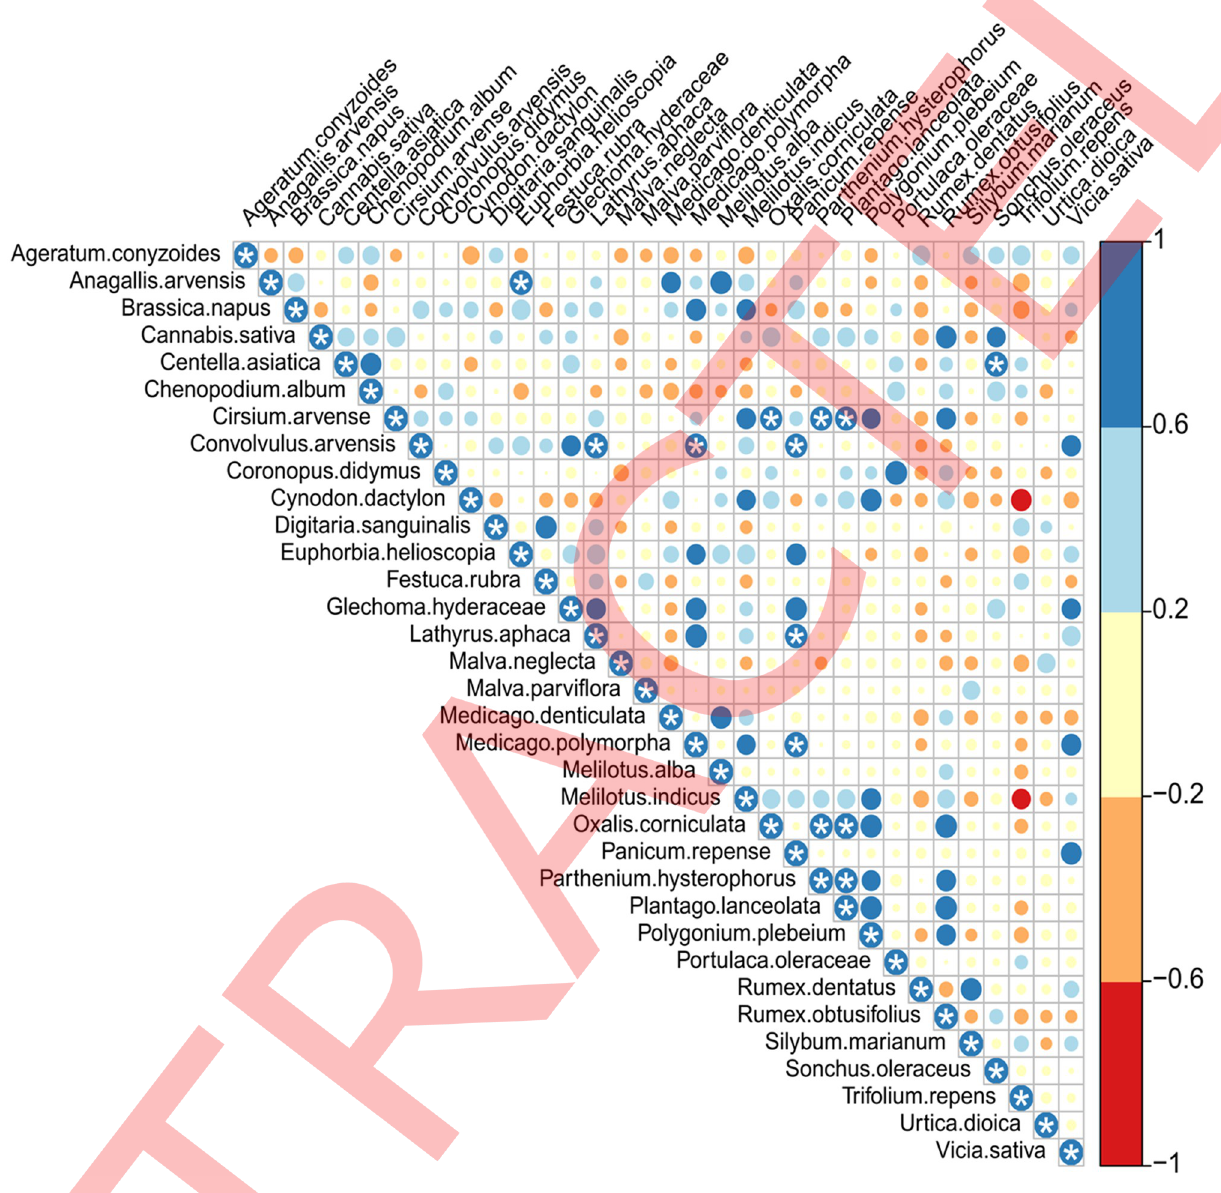
Fig 5. Correlation matrix of different weed species. Asterisk ( � ) sign denotes significant relationship (p �